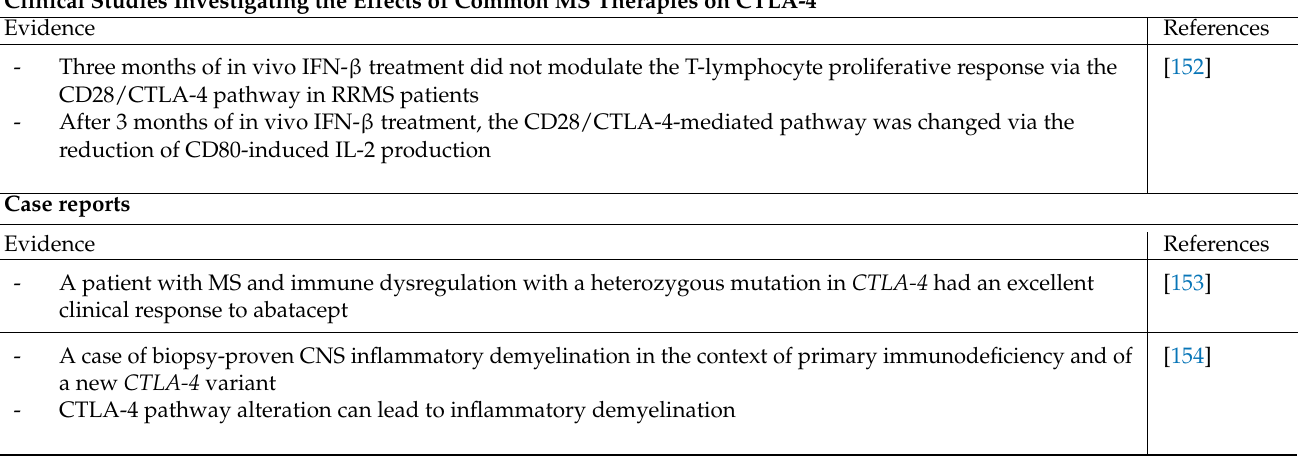
Table 4. Schematic overview of the most important evidence from the clinical studies investigating the effects of common MS therapies on CTLA-4 and from the case reports on CTLA-4 in